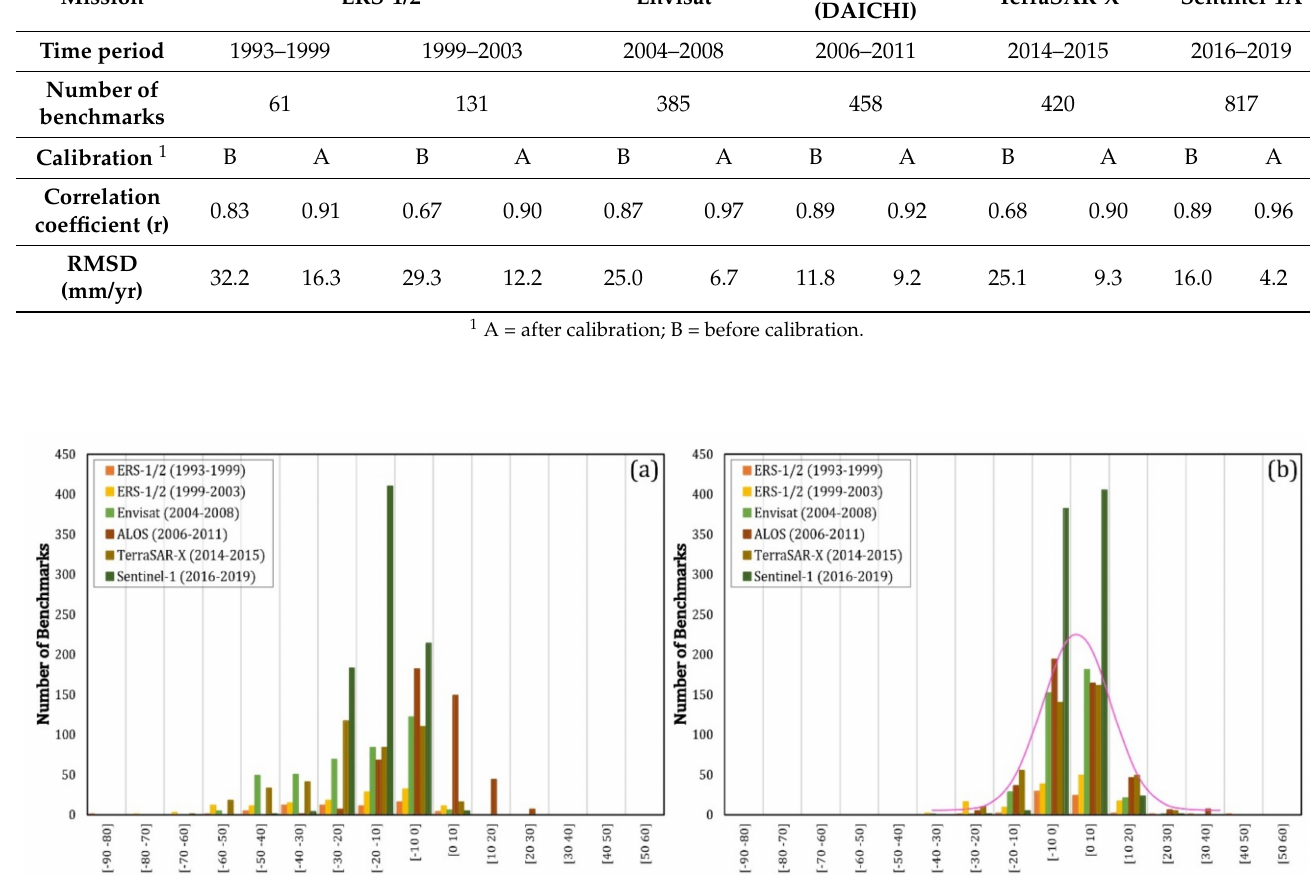
Table 2. Root mean squared differences between the velocities from leveling before (B) and after (A) the InSAR calibration. Mission Envisat